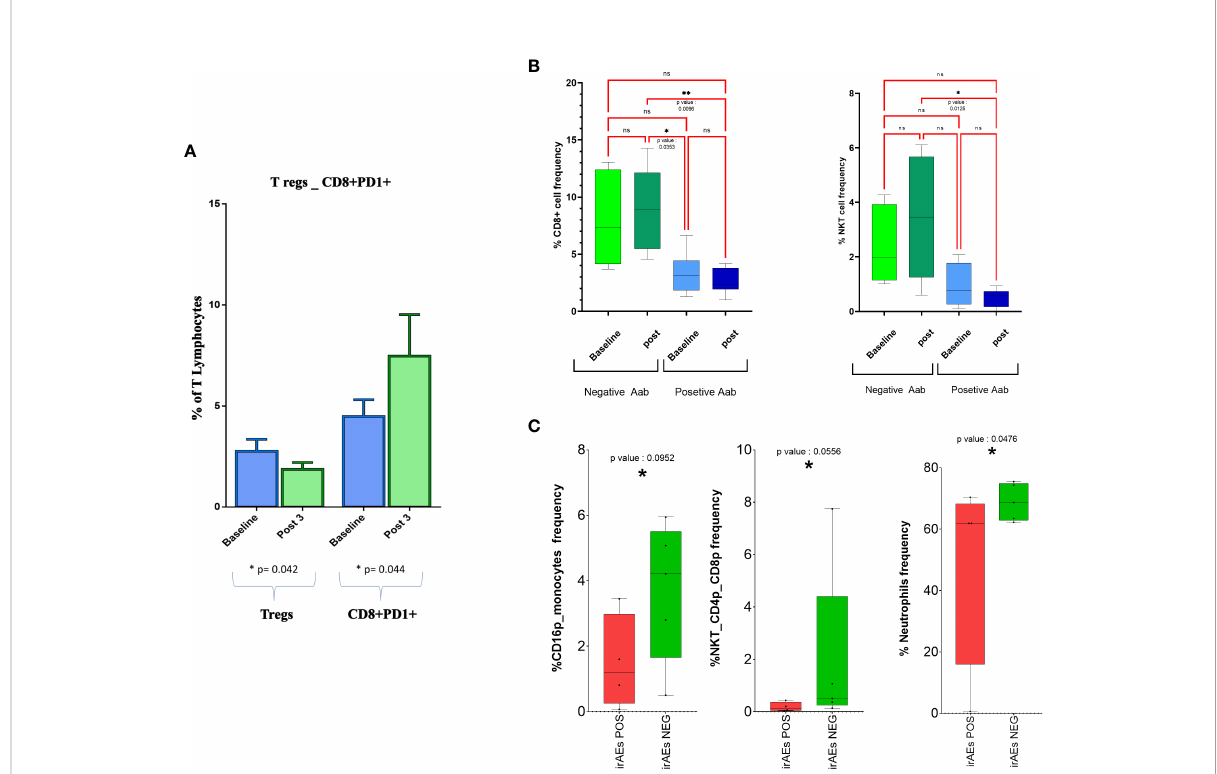
FIGURE 3 CD8 + T cells and NKT cell frequency changes in response to treatment in groups with different in fl ammatory and autoimmunity markers. (A) Boxplot representing changes on peripheral blood T + CD8 + T lymphocytes as effect of treatment. (B) Total percentage of different reg s and PD-1 cell subsets before and after therapy is reported for patients positive and negative for antinuclear antibodies (ANA, AAbs); only signi fi cant results are indicated. (C) Abundance of different cell subsets before and after therapy is reported for patients experiencing or not irAEs. Cell subsets with p- value < 0.1 only are represented. NKT, natural killer T; irAEs, immuno-related adverse events. *= pvalue<0.05. , **= p value<0.01 ns, not signi fi